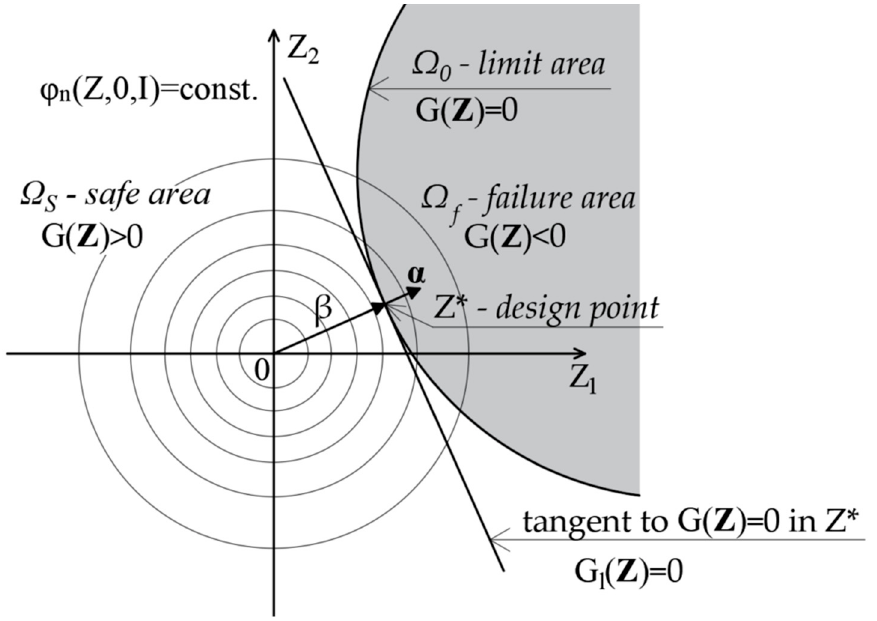
Figure 5. The first-order approximation of the failure probability value.